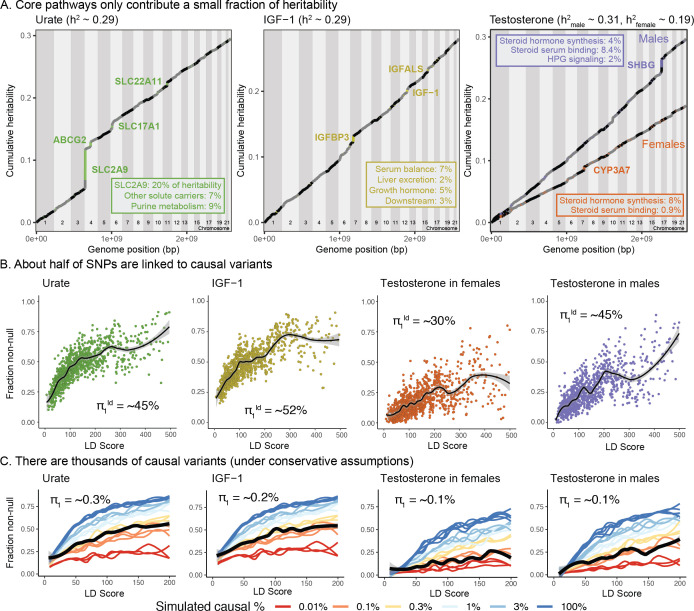
Despite clear enrichment of core genes and pathways, most SNP-based heritability for these traits is due to the polygenic background.(A) Cumulative distribution of SNP-based heritability for each trait across the genome (estimated by HESS). The locations of the most significant genes are indicated. Insets show the fractions of SNP-based heritability explained by the most important genes or pathways for each trait. (B) Estimated fractions of SNPs with non-null associations, in bins of LD Score (estimated by ashR). Each point shows the ashR estimate in a bin representing 0.1% of all SNPs. The inset text indicates the estimated fraction of variants with a non-null marginal effect, that is, the fraction of variants that are in LD with a causal variant. (C) Simulated fits to the data from (B). X-axis truncated for visualization as higher LD Score bins are noisier. Simulations assume that π1 of SNPs have causal effects drawn from a normal distribution centered at zero (see Materials and methods). The simulations include a degree of spurious inflation of the test statistic based on the LD Score intercept. Other plausible assumptions, including clumpiness of causal variants, or a fatter-tailed effect distribution would increase the estimated fractions of causal sites above the numbers shown here.